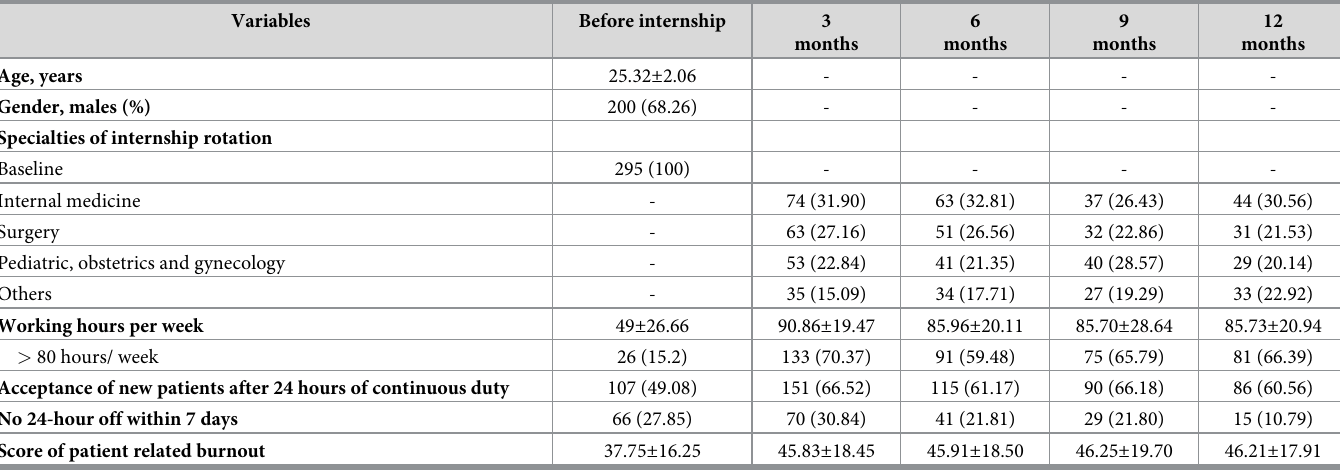
Table 1. Characteristics at baseline and follow-ups.